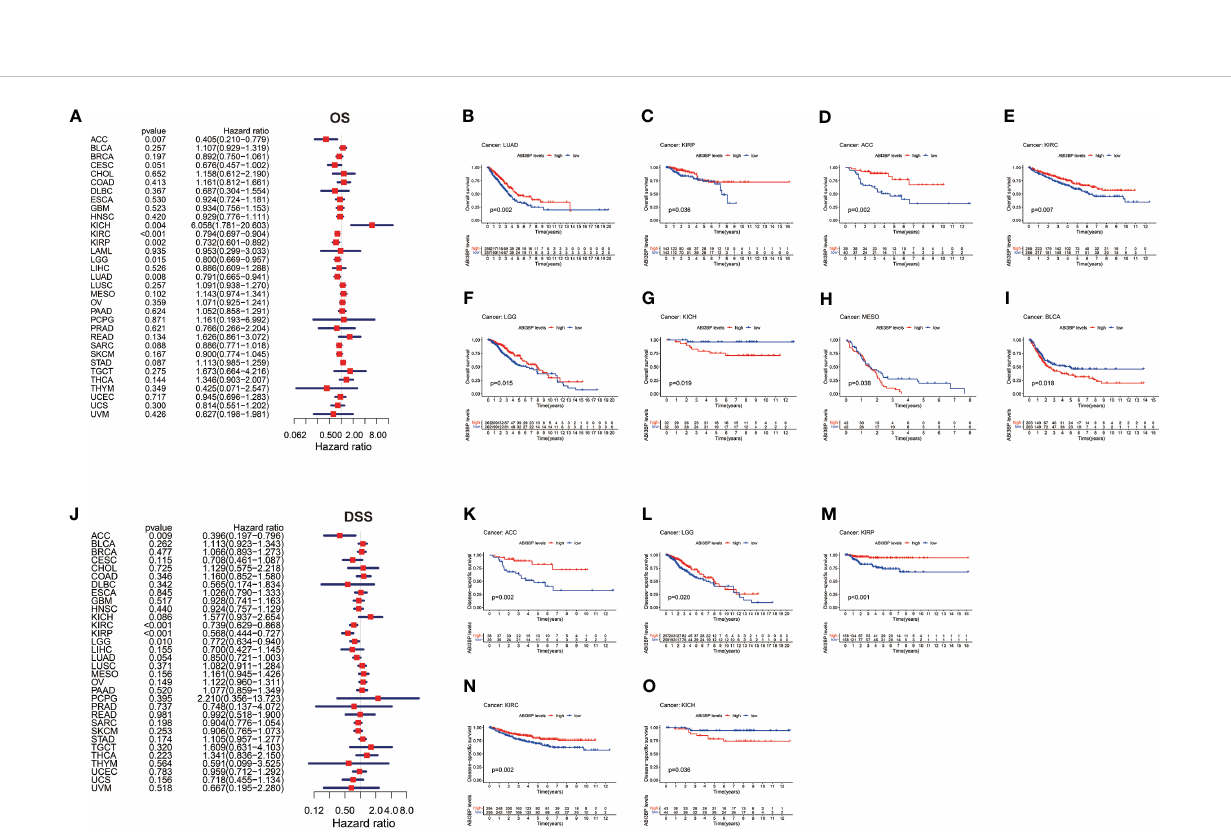
FIGURE 3 Univariate Cox regression analysis of ABI3BP. (A) Forest plot shows the results of univariate cox regression of ABI3BP on OS in TCGA database. (B-I) The K-M survival curve showed the OS prognosis of LUAD, KIRP, ACC, KIRC, LGG, KICH, MESO and BLCA patients in the ABI3BP high and low expression groups. (J) Forest plot shows the univariate cox regression results of ABI3BP on DSS in TCGA database. (K-O) The K-M survival curve showed the DSS prognosis survival of ACC, LGG, KIRP, KIRC and KICH patients in the ABI3BP high and low expression groups.